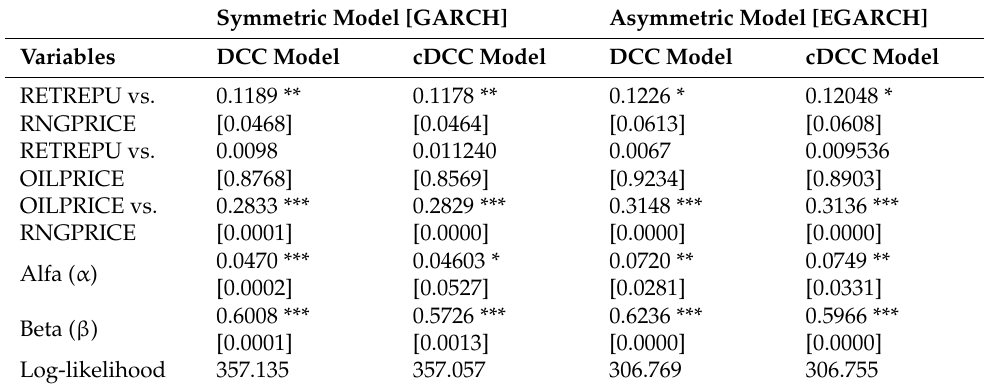
Table 4. Parameter estimates of MGARCH